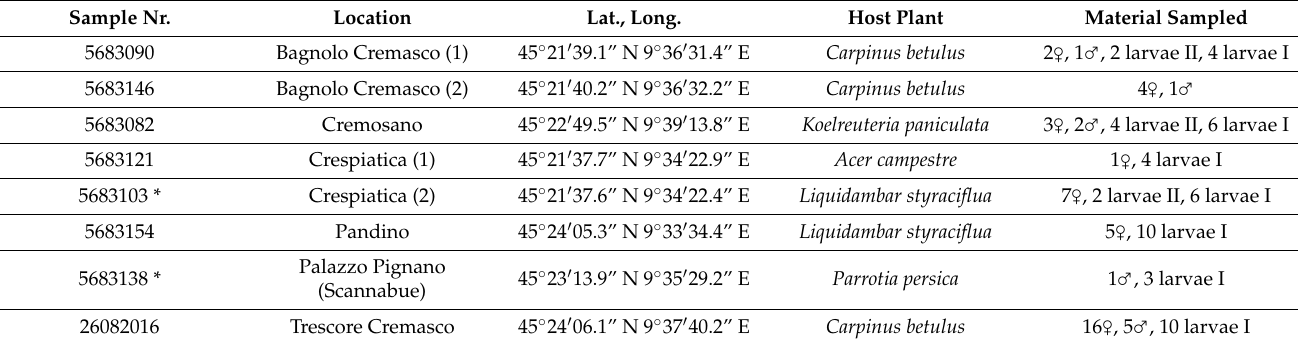
Table 2. Records of Selenothrips rubrocinctus sampled on 24 June 2019 in Italy (Lombardia). Samples from Trescore Cremasco were collected in 2016. Sample